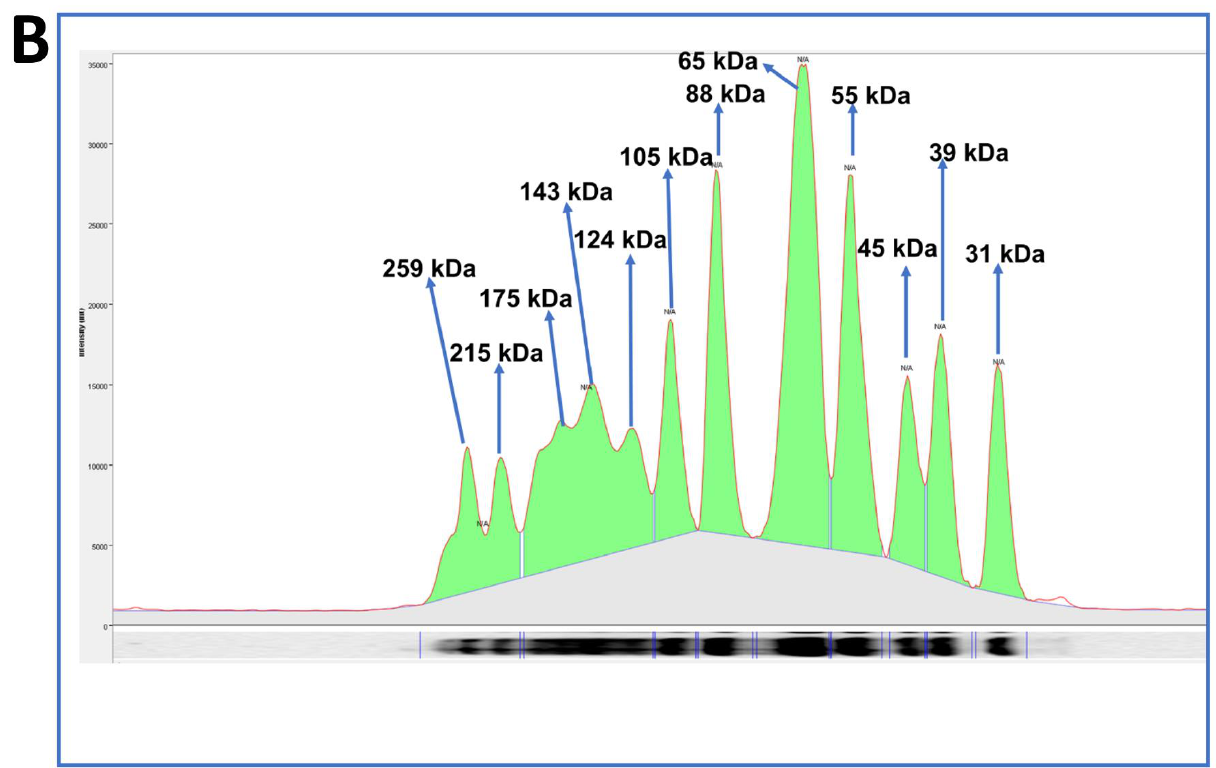
Figure 9. Western blot probing for JAM-B protein in samples of recombinant JAM-B protein and THP- 1 monocyte whole cell lysates. All samples were separated by SDS-PAGE under reducing conditions using DTT. ( A ) Recombinant protein ( left panel , lane 1) run together with protein molecular weight marker ( left panel , lane 2) and cell lysates from unstimulated ( right panel ) and LPS- ( right panel ) or TNF α - ( right panel ) stimulated THP-1-cultured cells ( right panel ); ( B ) example chromatogram demonstrating band molecular weights and grouping to aid quantification. Representative images of more than three technical